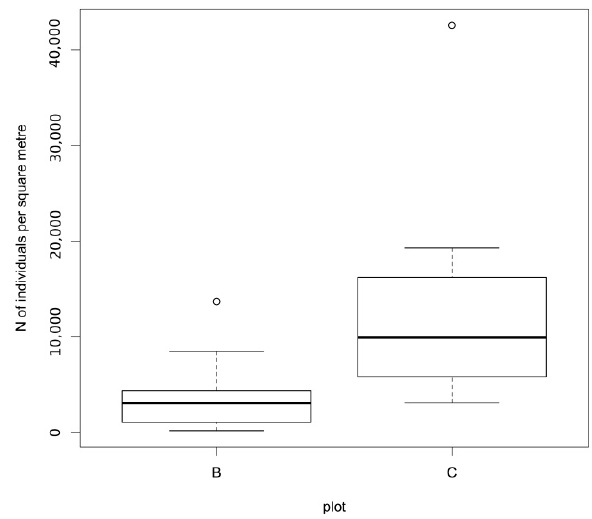
Figure 2. Abundance of Collembola in plots bioturbated by wild boar (B) and control plots (C).